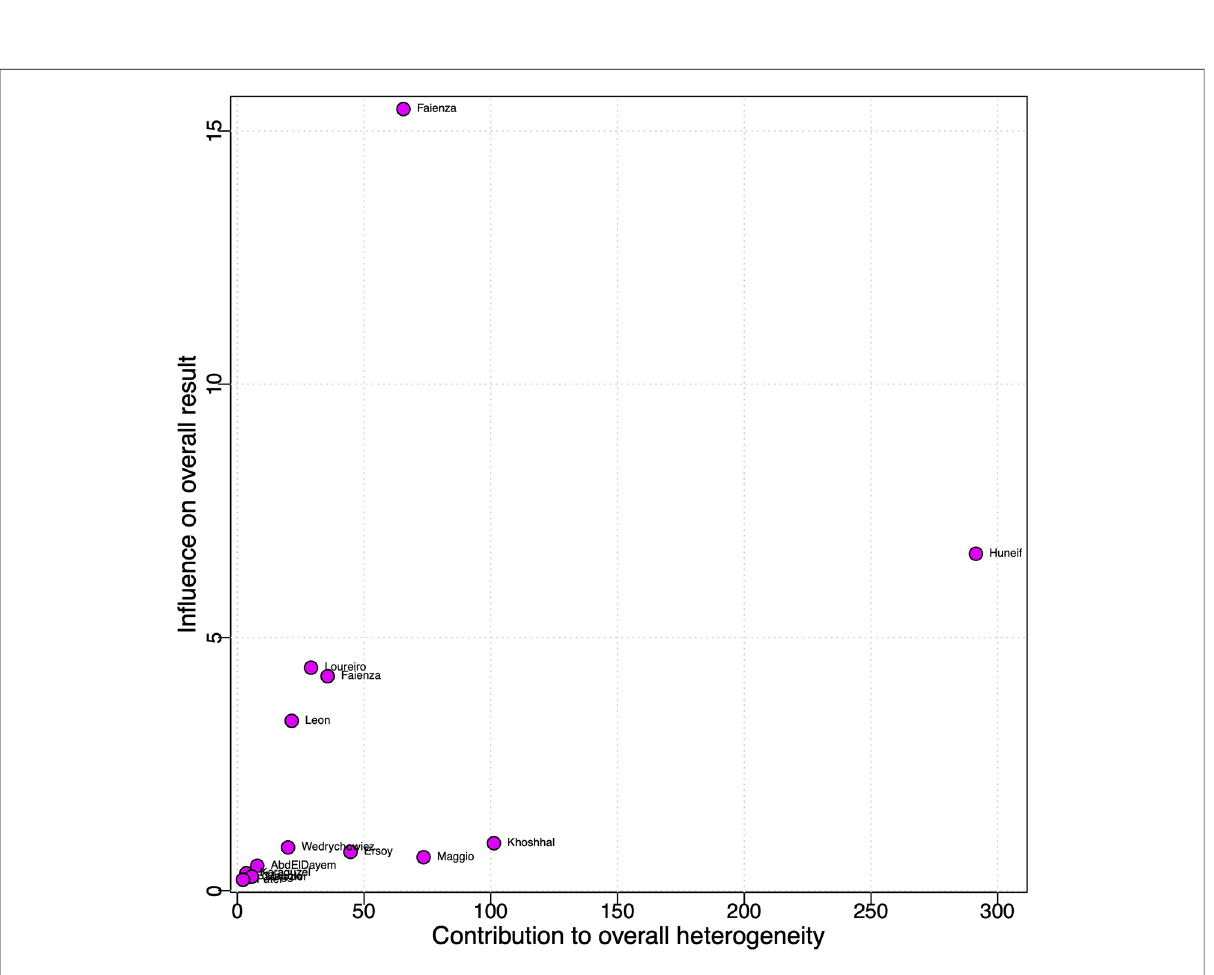
FIGURE 3 Baujat plot for analysis of the contribution of each study to heterogeneity in tOC serum levels.